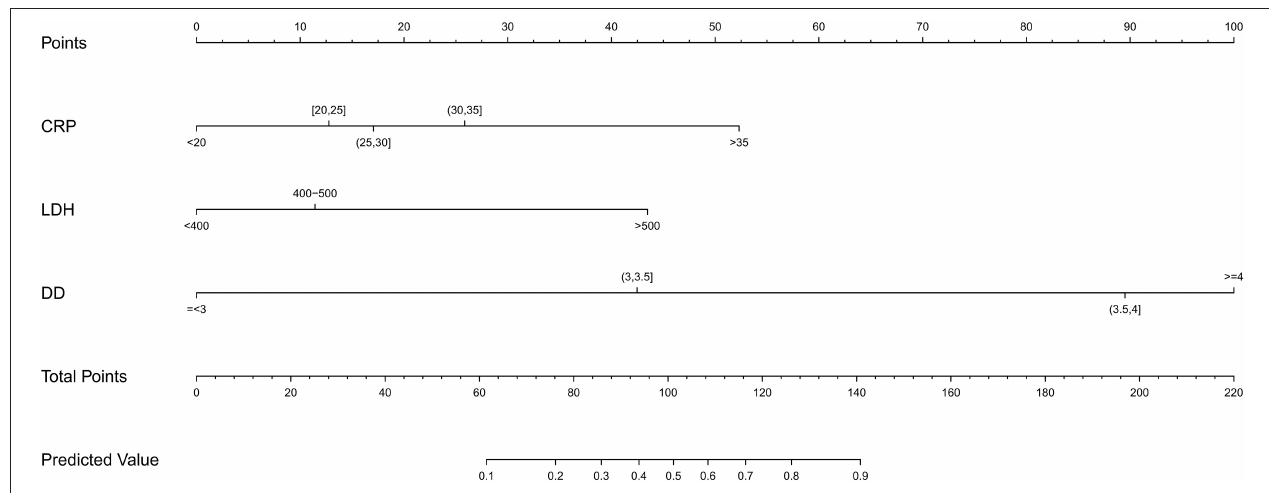
FIGURE 1 | Construct a nomogram of risk for RMPP children. A nomogram predicting the risk of RMPP was established based on the three independent risk factors (CRP level, D-dimer level, and LDH level). You can specify points for each variable by drawing a line up from the corresponding variable to the point line. The sum of the points plotted on the Total Points line and the risk value corresponding to the RMPP risk score represented the specific risk at which the RMPP occurred.